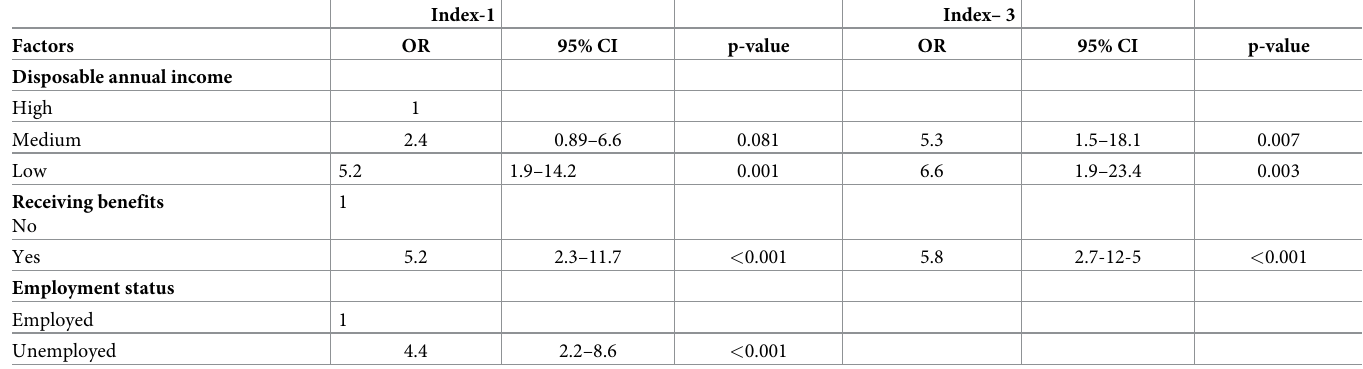
Table 3. Bivariable associations between selected socio-demographic factors for male perpetrators and male controls, crude odds ratios (OR) with 95% confidence intervals (CI). N = 528; 48 perpetrators and 480